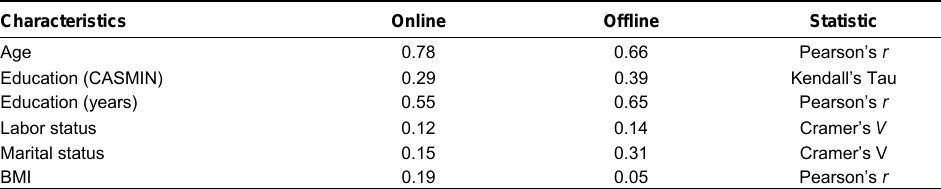
Measures of association on couple